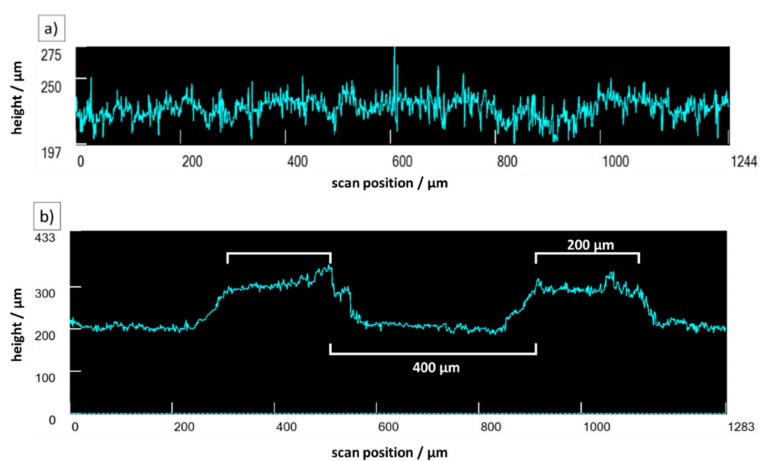
Figure 5. Line profiles of an unstructured ST1 ( a ) and a lattice-structured ST3 ( b ) silicon bond coat with 200 µm wide bridges and 400 µm basin structures, recorded by confocal microscopy.